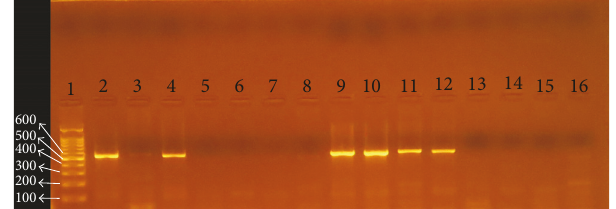
Figure3:PCRproductsfor H.pylori with iceA1 gene-basedprimers. The product size is 558 bp. Lane 1 is a ladder. Lanes 2–16 are patients’ biopsy samples.